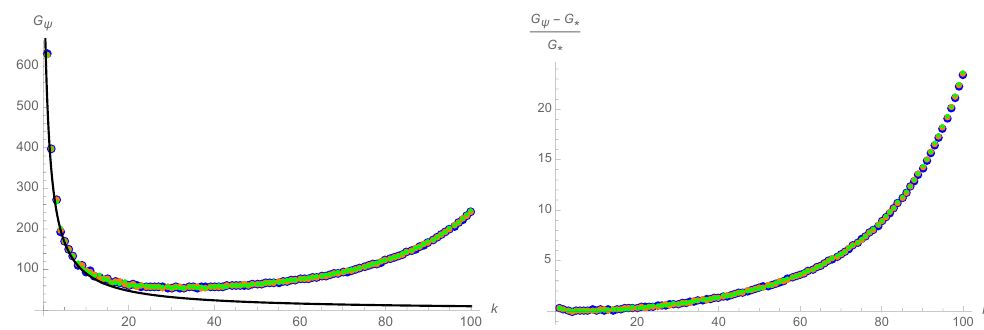
Figure 5 . (Left) The two-point function G as a function of k , for three particular microstates denoted by blue, orange and green points (the points are almost overlapping so we have chosen di(cid:11)erent point-sizes to make them more visible), which are linear combinations of (cid:12)ve tableaus close to the typical one, but chosen randomly. For comparison, we have also shown the large- N result from the superstar ensemble with ! = 1 (black line). (Right) The relative deviation of the two-point function from that in the superstar ensemble as a function of k . Here N =